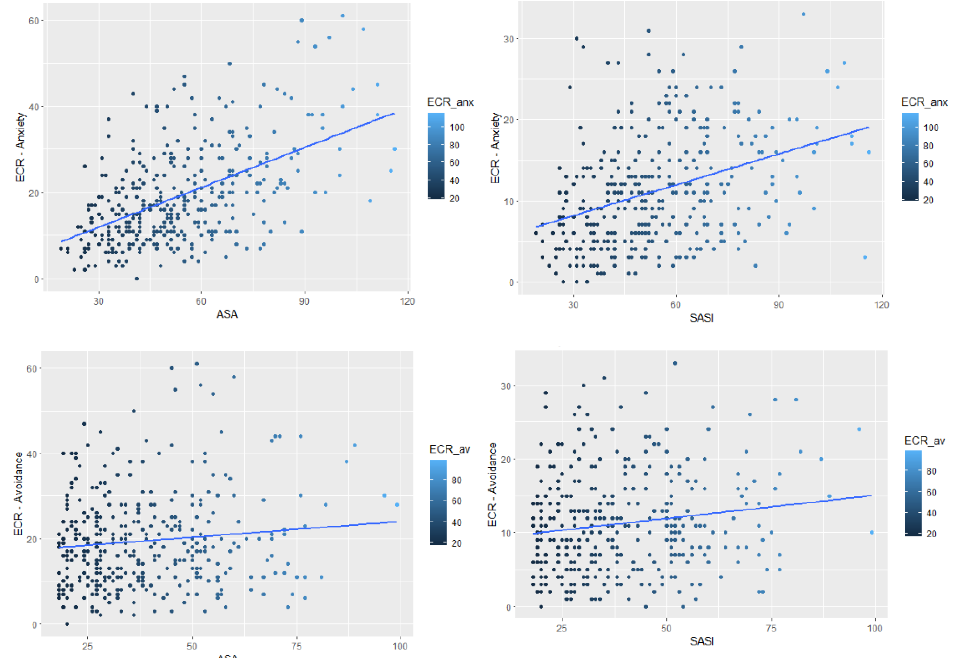
Figure 1. Scatterplot of the linear association between both ECR-Anxiety and ECR-Avoidance and ASA-27 and SASI.